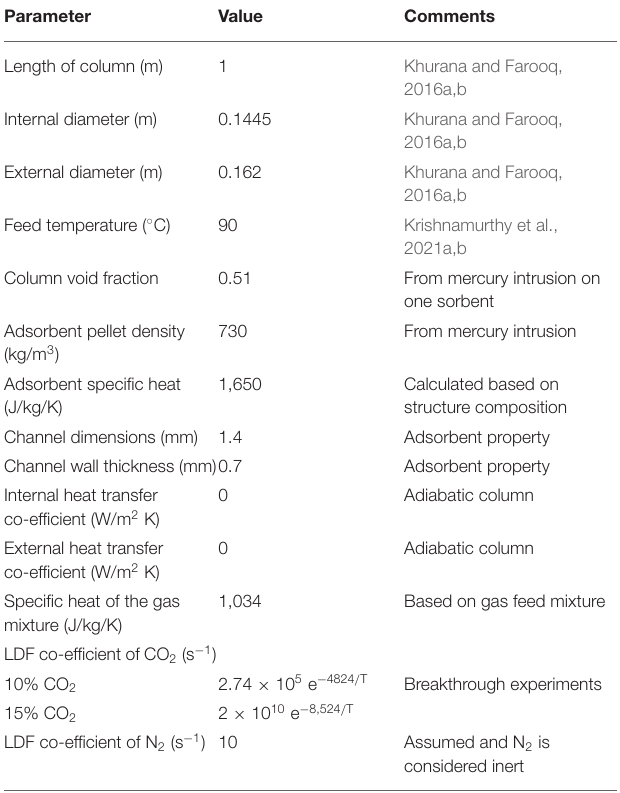
TABLE 4 | Input parameters for the process simulation.